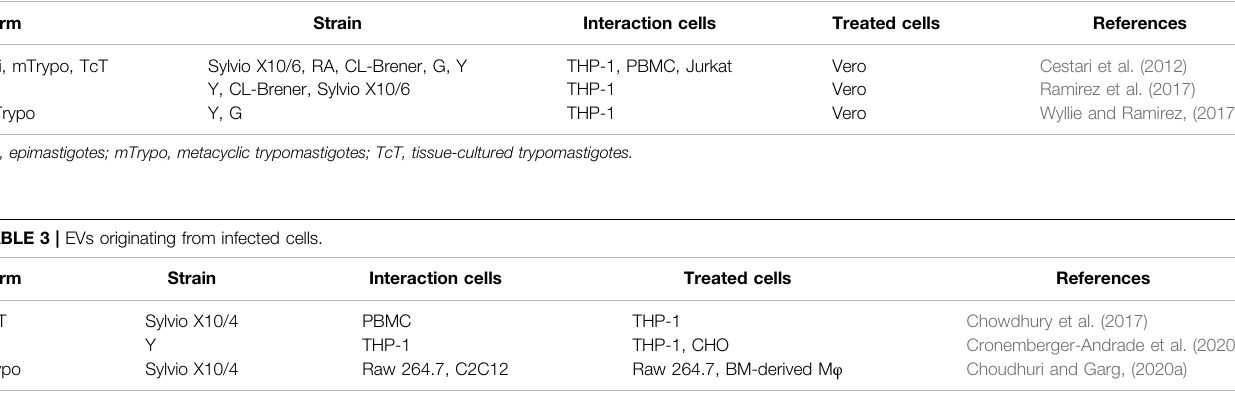
TABLE 2 | EVs originating from the interaction between the host cells and parasites.